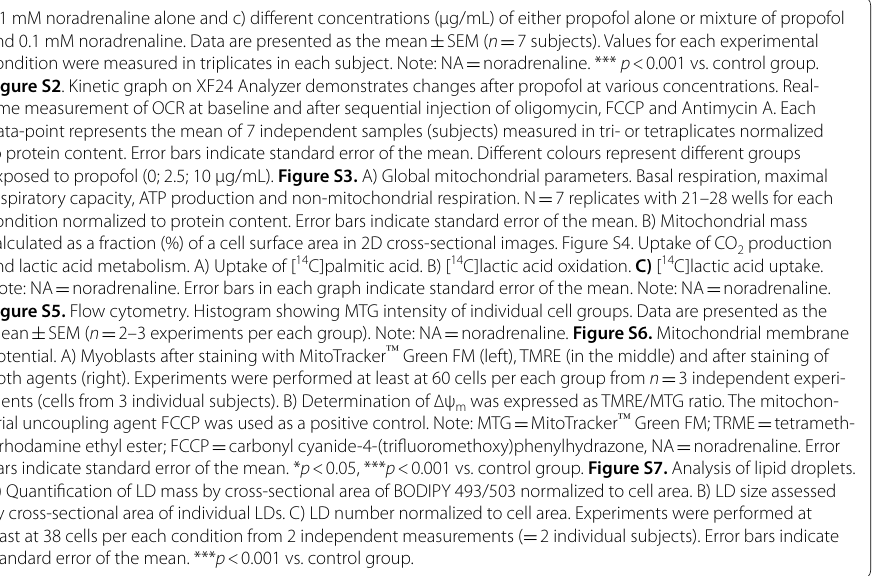
Figure S2 . Kinetic graph on XF24 Analyzer demonstrates changes after propofol at various concentrations. Real- time measurement of OCR at baseline and after sequential injection of oligomycin, FCCP and Antimycin A. Each data-point represents the mean of 7 independent samples (subjects) measured in tri- or tetraplicates normalized to protein content. Error bars indicate standard error of the mean. Different colours represent different groups exposed to propofol (0; 2.5; 10 µg/mL). Figure S3. A) Global mitochondrial parameters. Basal respiration, maximal respiratory capacity, ATP production and non-mitochondrial respiration. N 7 replicates with 21–28 wells for each = condition normalized to protein content. Error bars indicate standard error of the mean. B) Mitochondrial mass calculated as a fraction (%) of a cell surface area in 2D cross-sectional images. Figure S4. Uptake of CO 2 production and lactic acid metabolism. A) Uptake of [ 14 C]palmitic acid. B) [ 14 C]lactic acid oxidation. C) [ 14 C]lactic acid